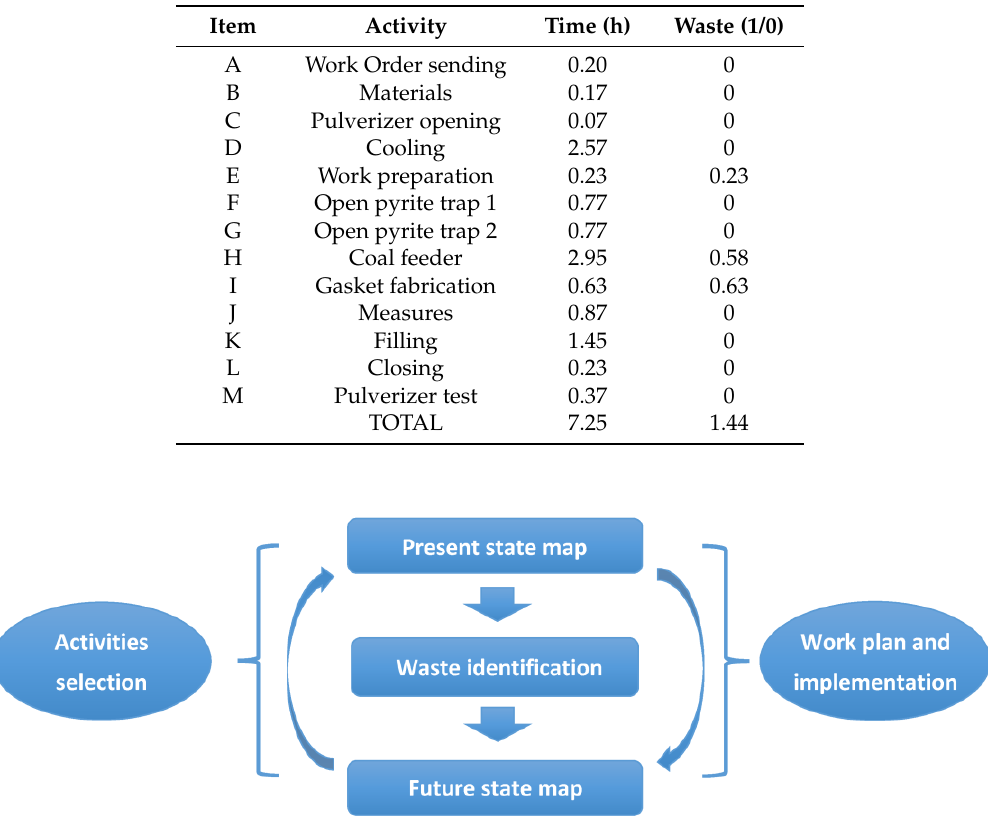
Table 7. List of activities performed during the maintenance of pulverizers.